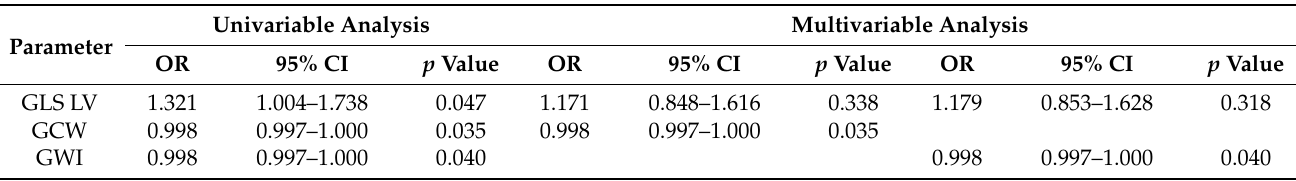
Table 2. Predictors of persistent dyspnea in COVID-19-recovered